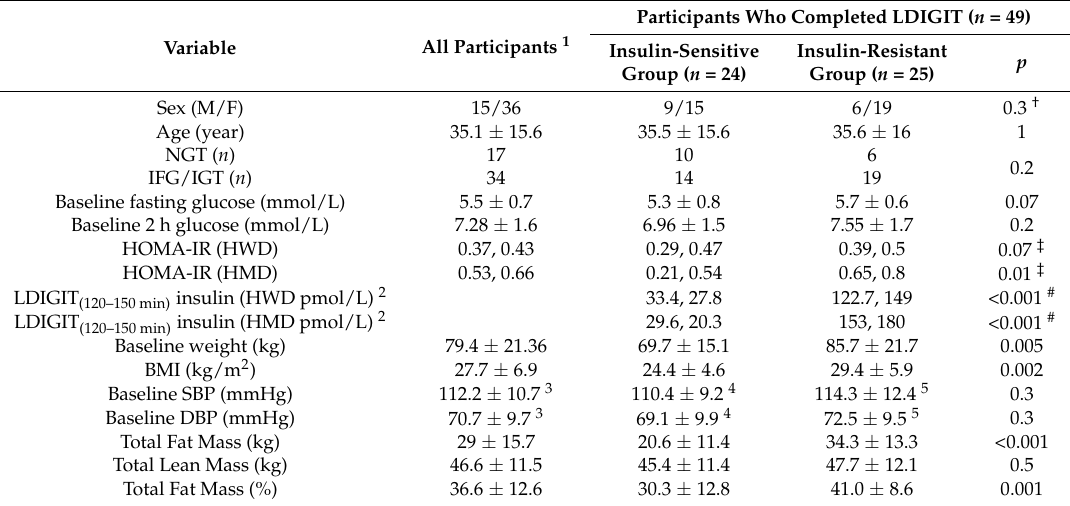
Table 1. Baseline characteristics of